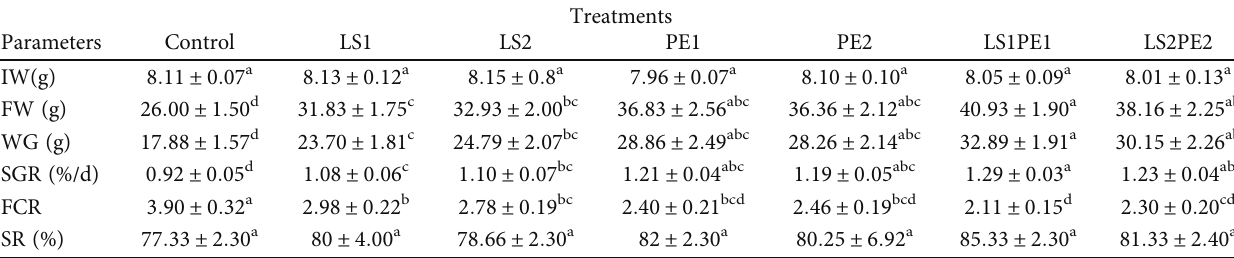
Note: Di ff erent letters in each column show signi fi cant di ff erences among the experimental groups ( P < 0 : 05 ). Values are shown as mean ± SD ( n = 3 ). Abbreviations: IW: initial weight (g); FW: fi nal weight (g); WG: weight gain (g); SGR: speci fi c growth rate (%/d); FCR: feed conversation rate; SR: survival rate (%).